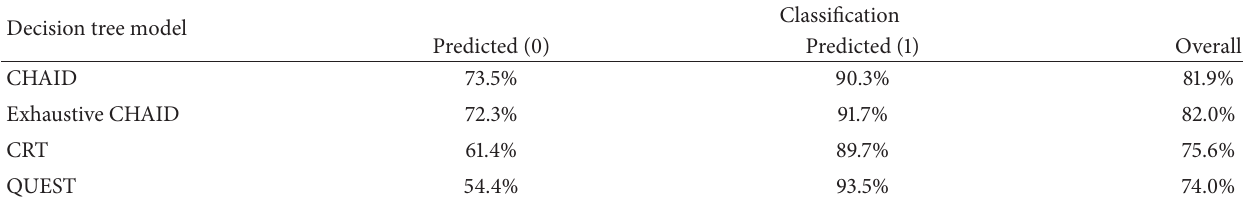
Table 3: Classification accuracy produced by each model.